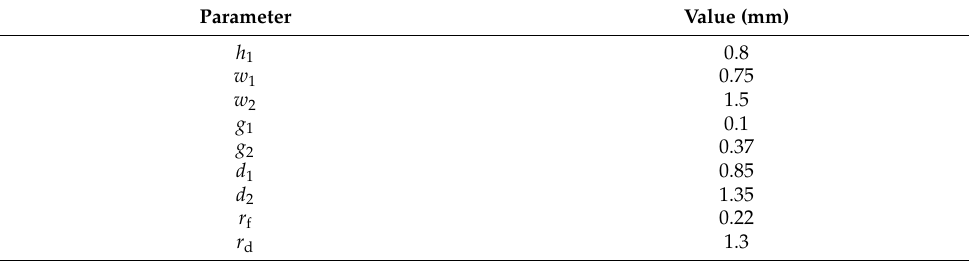
Table 1. Optimal design parameters of the interface